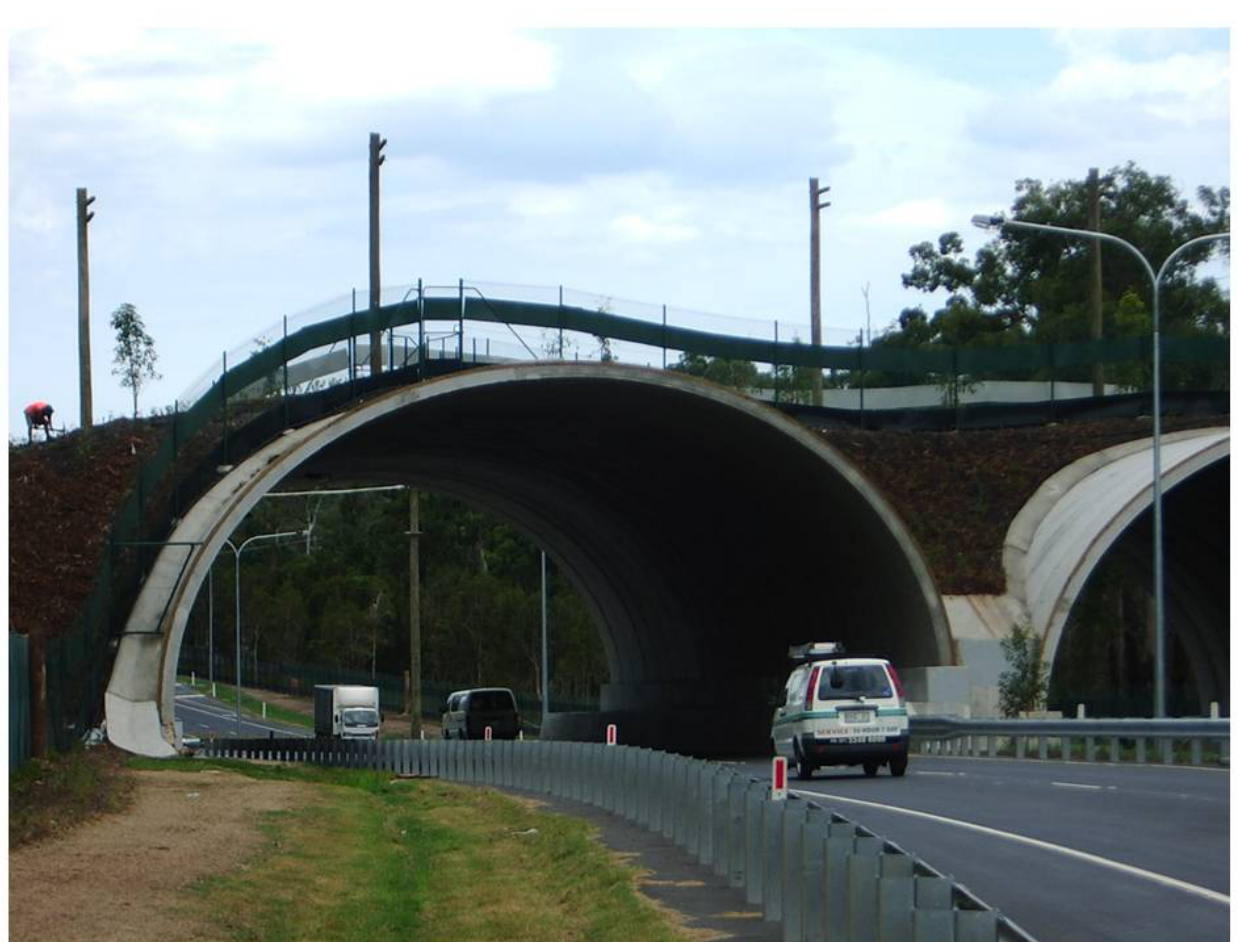
Fig. 3. Land bridge with gliding poles taken 1 month after installation. Photo: